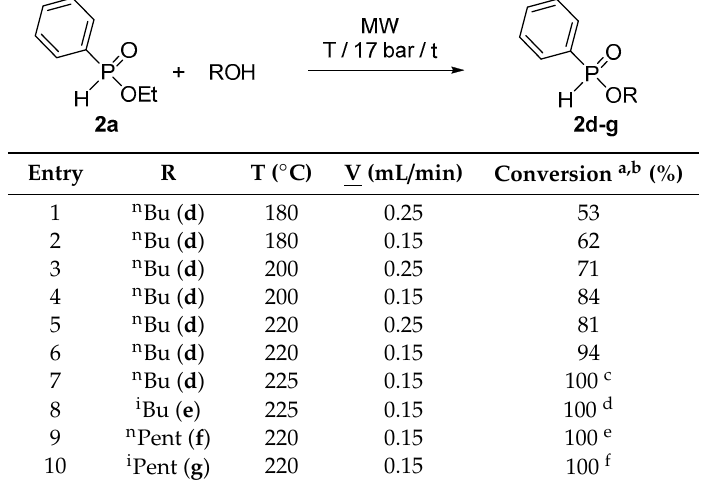
Molecules 2020 , 24 , x Table 4. Transesterification of 2a with n-butanol in a flow MW reactor in a concentration of 0.1 g / mL.